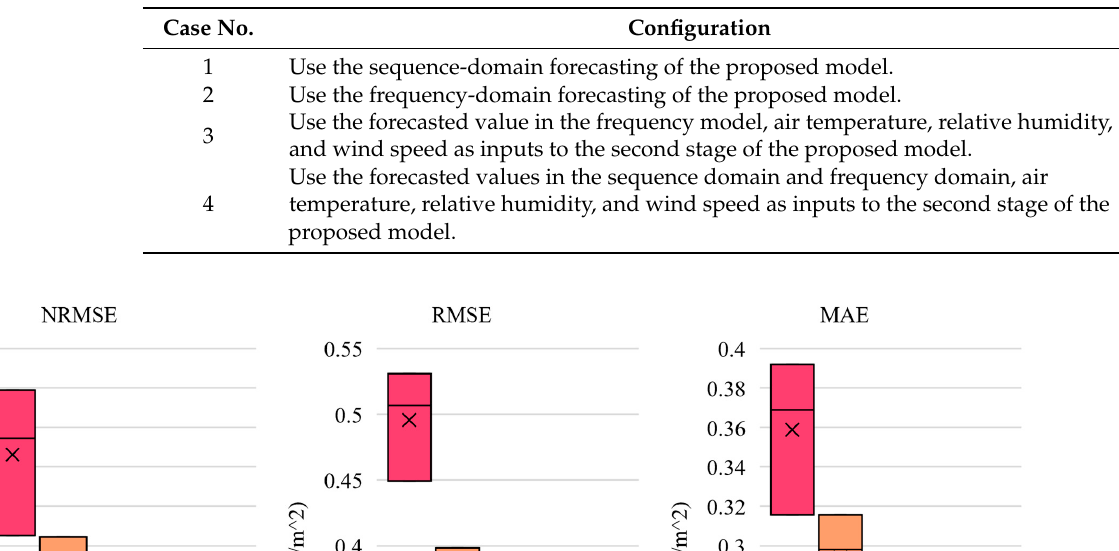
Table 8. Configuration of the ablation studies.